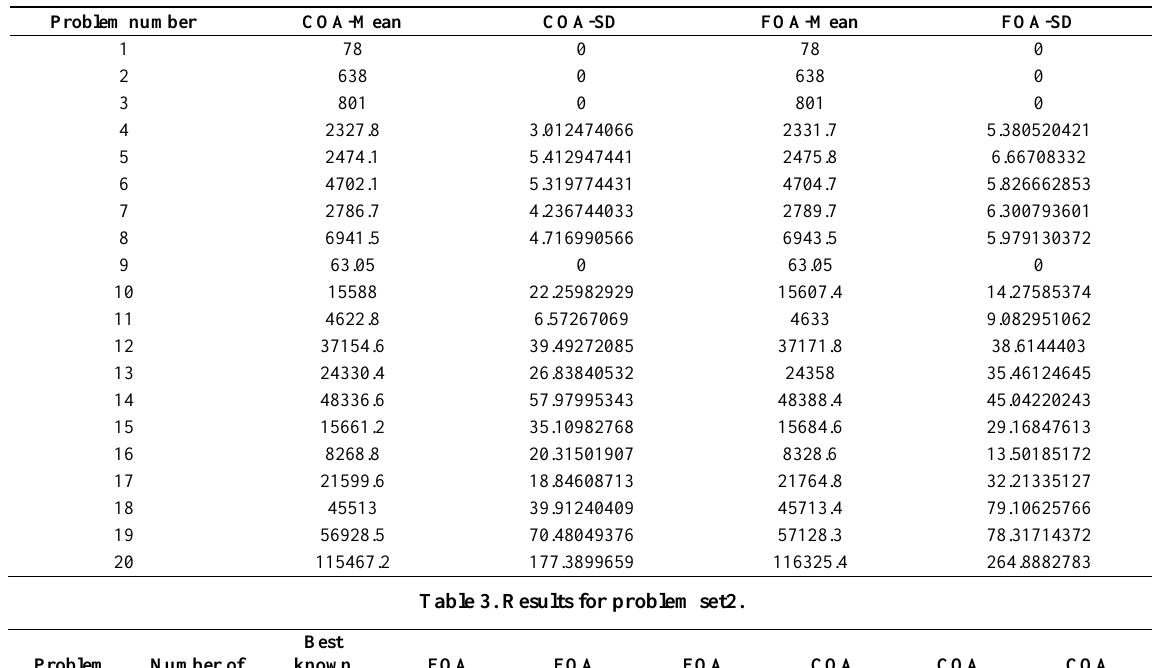
Table 2. Mean and SD results for instances of set one in 20 times of run.